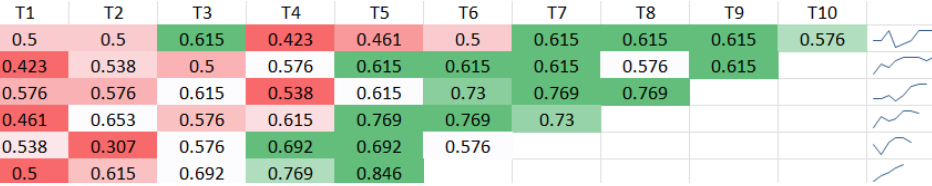
Figure 6. Models’ performance